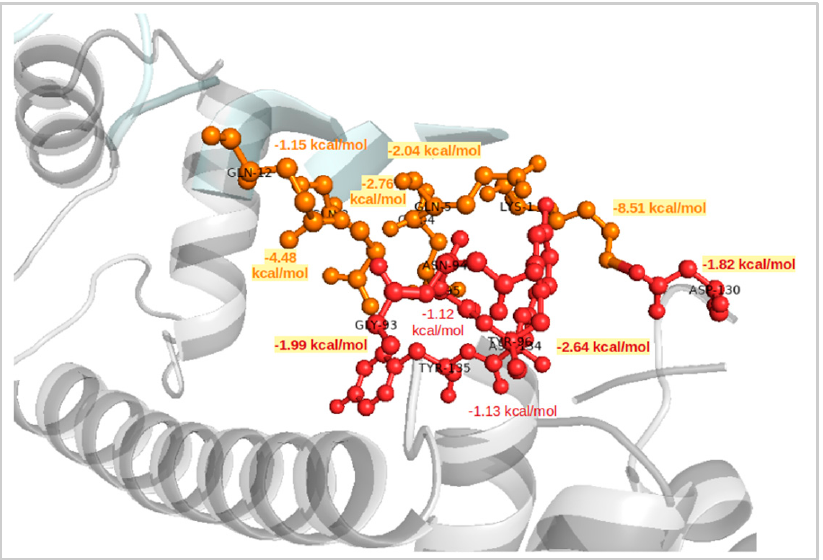
Figure 3. Per ‐ residue contributions for CaM and wt ‐ HTT docked complex and their corresponding binding free energies.